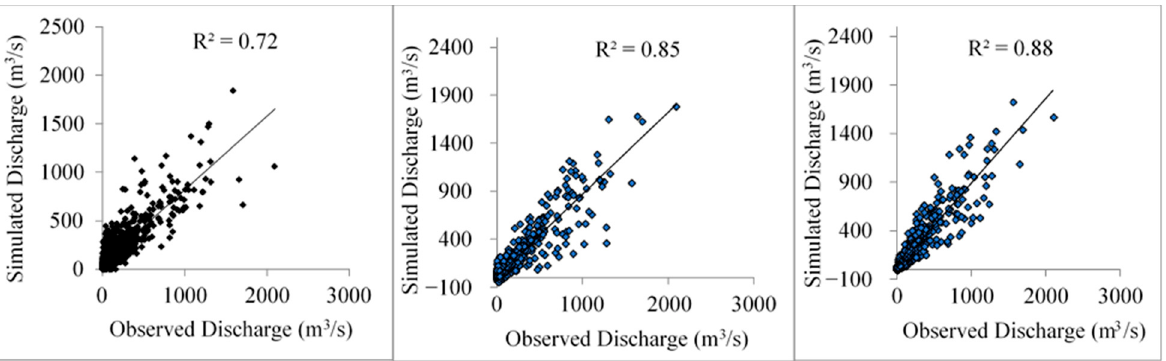
Figure 9. Scatter plot of daily simulated and observed discharge for SWAT ( left ), ARX ( middle ), and GEP ( right ) during calibration. Table 2. Model parameters used to calibrate discharge of Kentucky River at LD14. Ranges of calibrated parameters reflect values for different land use/cover and soil types.